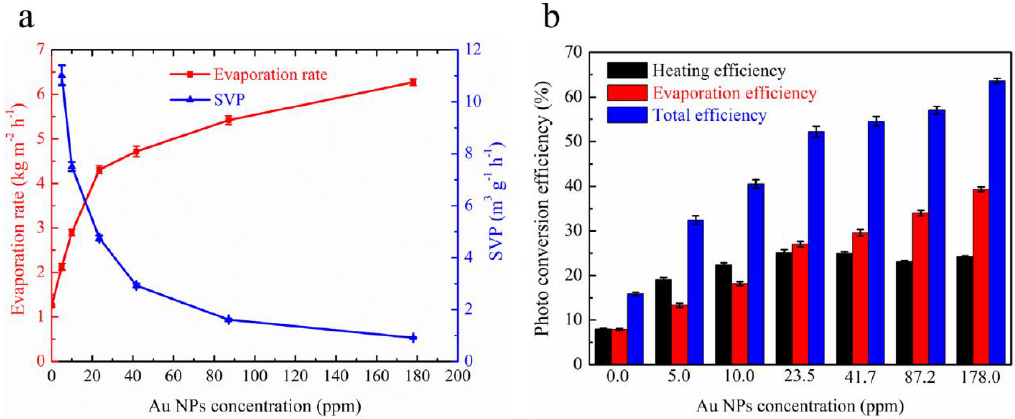
Figure 20. ( a ) Evaporation rate and specific vapor productivity (SVP) change as a function of Au nanoparticle concentration; ( b ) heating efficiency, evaporation efficiency, and total efficiency during solar steam generation [44]; 2017, Elsevier.